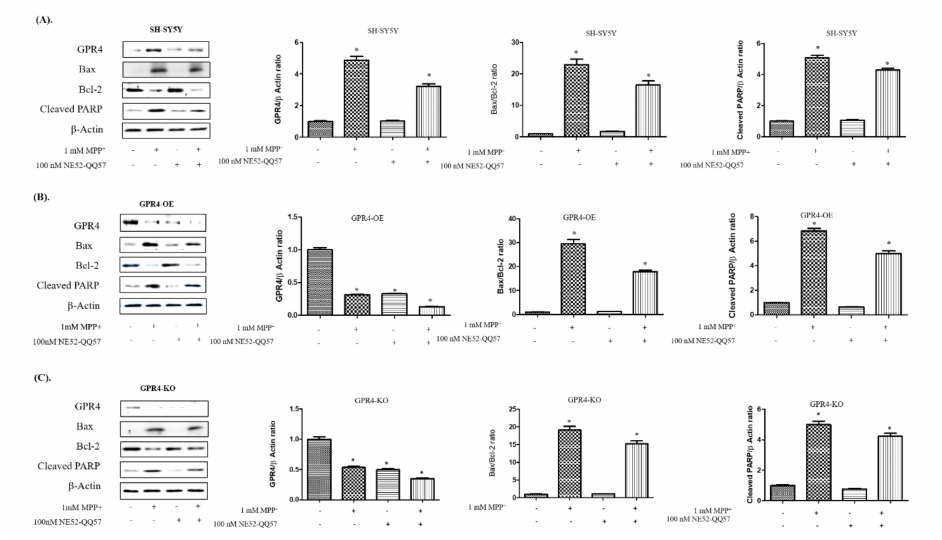
Figure 5. The e ff ect of GPR4 antagonist, NE52-QQ57, on the GPR4 and pro-apoptotic protein expressions in MPP + -treated SH-SY5Y cells that were stably GPR4-OE or GPR4-KO. 24 h serum-starved SH-SY5Y cells were pre-treated for 1 h with NE52-QQ57 (100 µ M); this was followed by MPP + (1 mM) stimulation for 24 h in serum-free culture media. ( A ) An immunoblot and semi-quantification of the respective protein expressions of GPR4, Bax, Bcl-2, Cleaved PARP, and β -Actin in SH-SY5Y cells. ( B ) An immunoblot and semi-quantification of the respective protein expressions of GPR4, Bax, Bcl-2, cleaved PARP, and β -Actin in GPR4-OE cells. ( C ) An immunoblot and semi-quantification of the respective protein expressions of GPR4, Bax, Bcl-2, cleaved PARP, and β -Actin in GPR4-KO cells. β -Actin was utilised as an internal control. Mean ± SEM ( n = 3) was employed to express the data. Tukey’s multiple comparison test was performed using a one-way ANOVA. Each * p < 0.05 refers to the sample concentration compared with the same group of non-treated